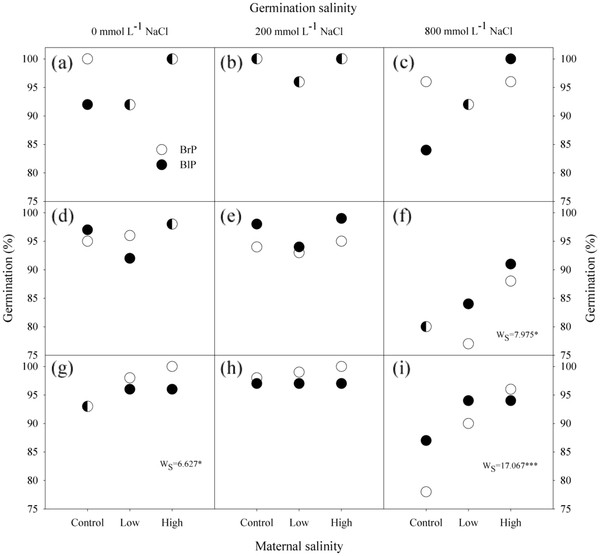
Effects of plant type and salinity on final germination percentages of brown seed cultivated from different gradients of nutrients and salt concentrations. (a, b, c) Low nutrient, (d, e, f) Moderate nutrient, (g, h, i) High nutrient. N: Nutrient; BrP: Plant grown from brown seed; BlP: Plant grown from black seed. W-values are given when significance levels are reached (S: salinity; * P < 0.05, *** P < 0.001). Over-lapping values are represented split white-black data points.